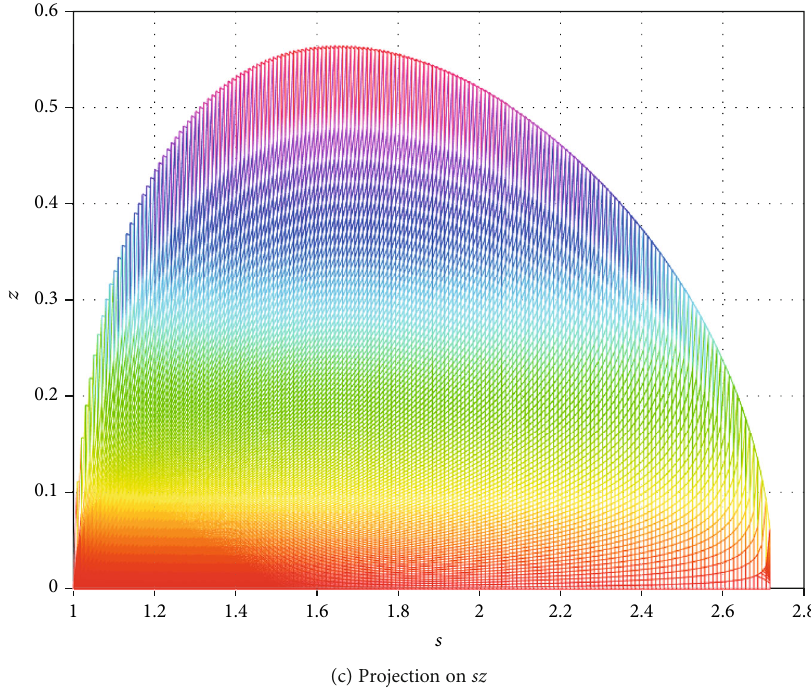
, s Þ for α = 3/2 α ð t